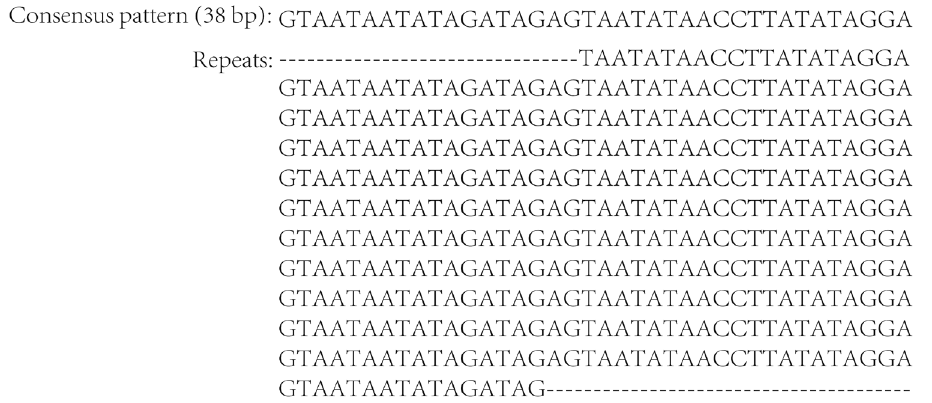
Figure 2. Sequences of the non-coding region in Asiomorpha coarctata, primary structures of tandemly repeated regions (11.4 × 38